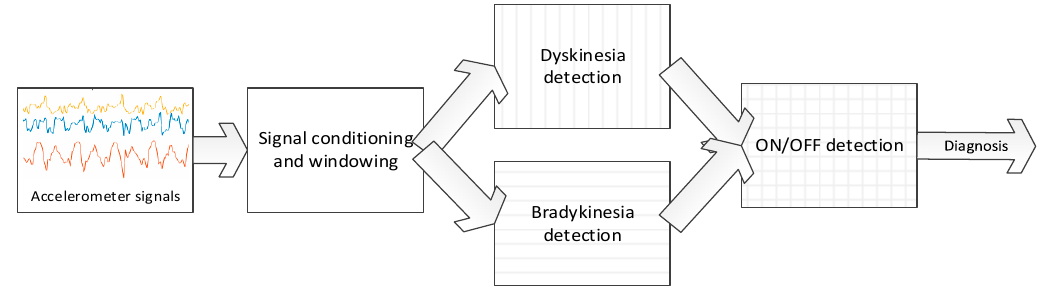
Figure 2. Block diagram of the dyskinesia, bradykinesia, and ON/OFF detection algorithms.